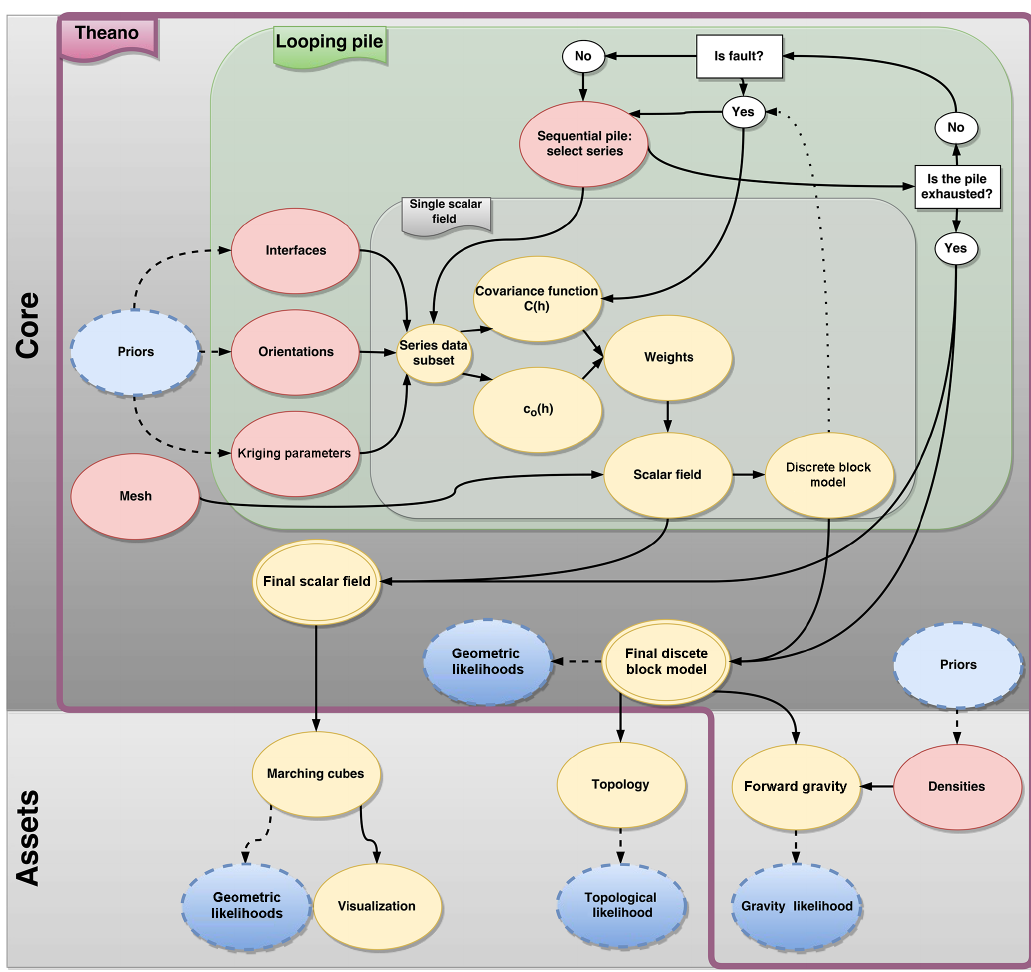
Figure 4. Graph of the logical structure of GemPy logic. There are several levels of abstraction represented. (i) The first division is between the implicit interpolation of the geological modeling (dark gray) and other subsequent operations for different objectives (light gray). (ii) All the logic required to perform automatic differentiation is presented under the Theano label (in purple). (iii) The parts under labels “Looping pile” (green) and “Single potential field” (gray) divide the logic to control the input data of each necessary scalar field and the operations within one of them. (iv) Finally, each superset of parameters is color coded according to their probabilistic nature and behavior in the graph: in blue, stochastic variables (priors or likelihoods); in yellow, deterministic functions; and in red, the inputs of the graph, which are either stochastic or constant depending on the